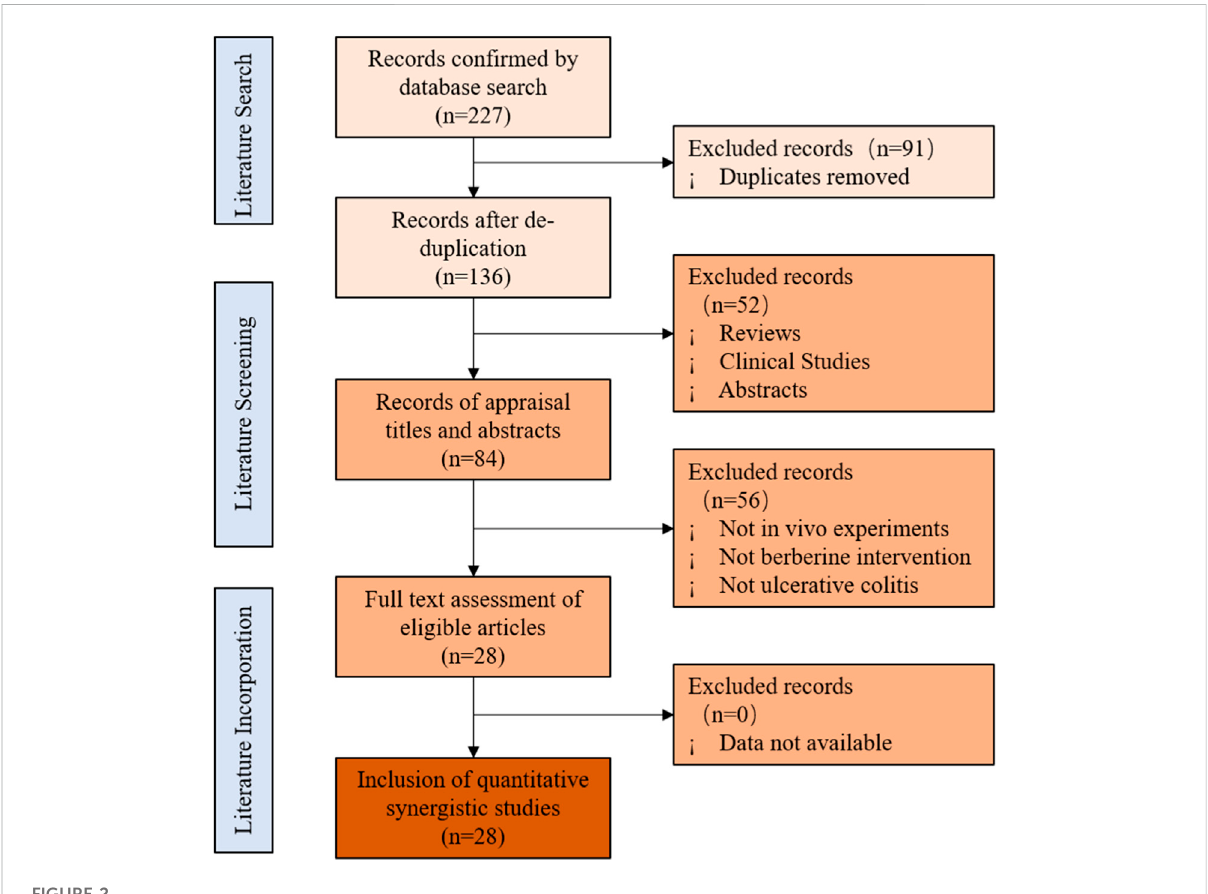
FIGURE 2 Flowchart of selection for studies